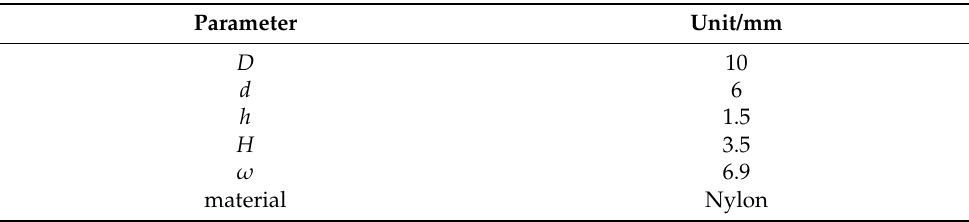
Table 2. Geometric parameters and material properties of the proposed continuum